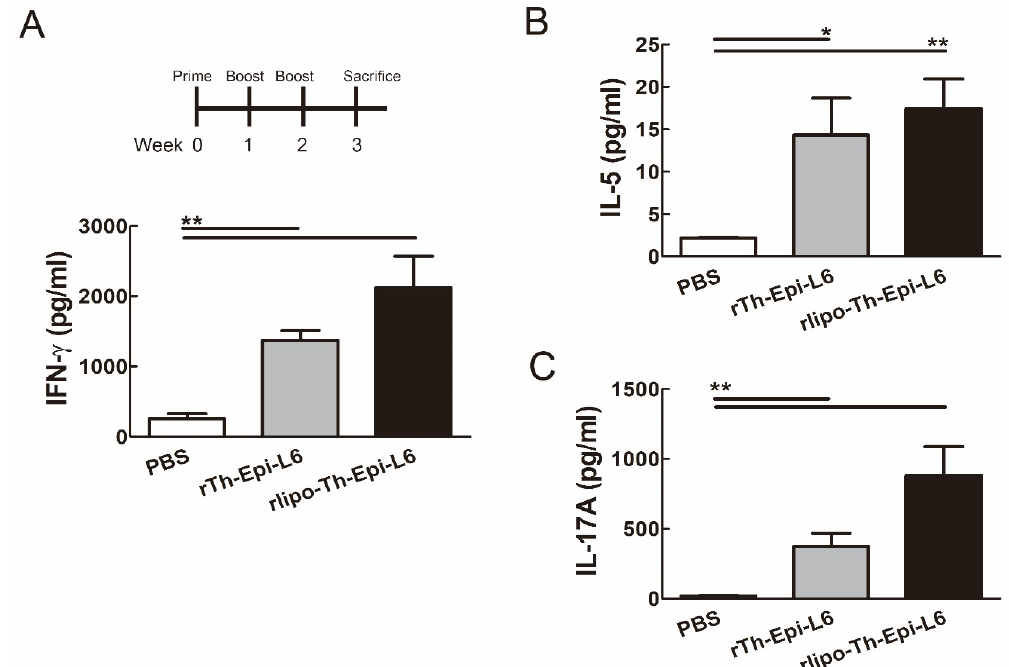
Figure 5. Immunization with rlipo-Th-Epi-L6 protein induced higher levels of cytokine release. ( A – C ) The immunization schedule in C57BL/6 mice ( n = 6, per group) involving injection of recombinant proteins 3 times at 1 ‐ week intervals. Seven days after the final immunization, mice were sacrificed, and splenocytes were isolated from the spleens and plated at a density of 5 × 10 5 cells/well in 24 ‐ well plates. The cells were incubated with 10 μ g/mL pan ‐ DR peptides for 4 days and then analyzed for secreted cytokines. The supernatants were collected, and the levels of IFN ‐γ ( A ), IL ‐ 5 ( B ), and IL ‐ 17A ( C ) were measured by ELISA. Bars and error bars show the mean ± SEM. * p < 0.05, ** p < 0.01 by t ‐ test.